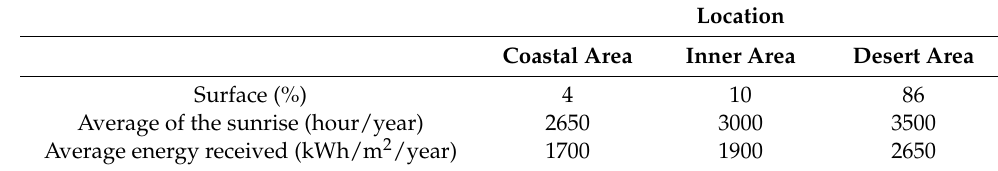
Table 1. Solar potential in Algeria [58].